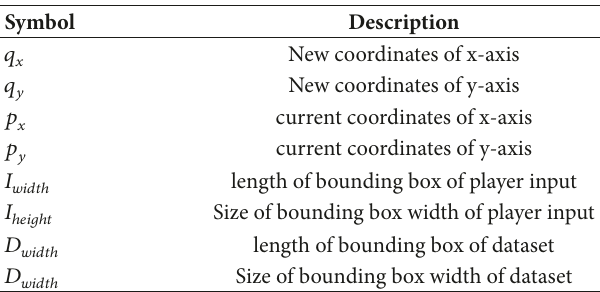
Table 7: Description of Formula Scale.